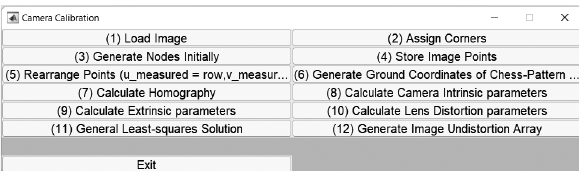
Figure 3. MATLAB ® application created for camera